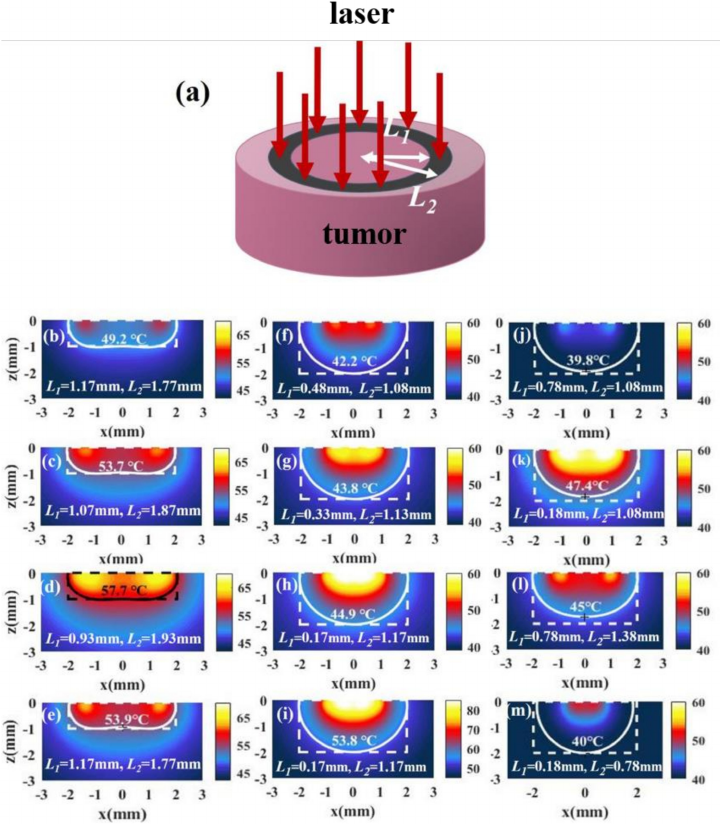
Figure 6. ( a ) Schematic of irradiation with ring light. ( b – d ) The temperature distributions of a tumor and the surroundings with I = 15 W/cm 2 and under different irradiation inner radius L 1 and outer radius L 2 in the case of z/ RT = 0.5 ( R T = 2 mm, z = 1 mm). ( e ) The temperature distribution in the case of L 1 = 1.17 mm and L 2 = 1.77 mm with I = 30 W/cm 2 . ( f – h , j – m ) The temperature distribution of a tumor and the surroundings with I = 15 W/cm 2 and different irradiation inner radius L 1 and outer radius L 2 in the case of z/ RT = 1 ( R T = 2 mm, z = 2 mm). ( i ) The temperature distribution in the case of L 1 = 0.17 mm and L 2 = 1.17 mm with I = 30 W/cm 2